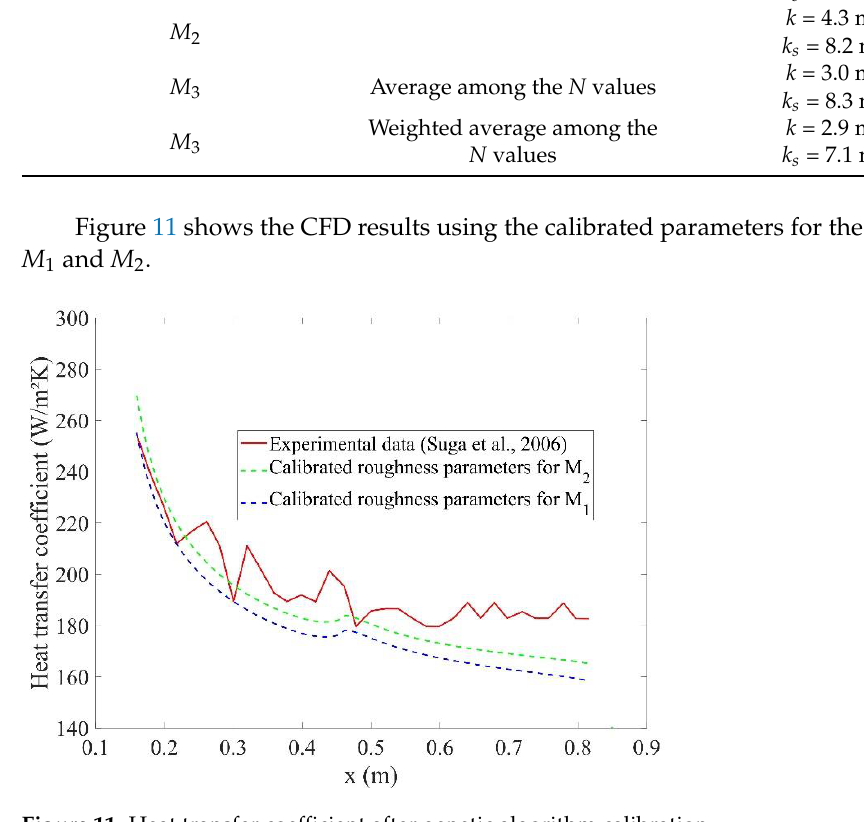
Figure 11. Heat transfer coefficient after genetic algorithm calibration.